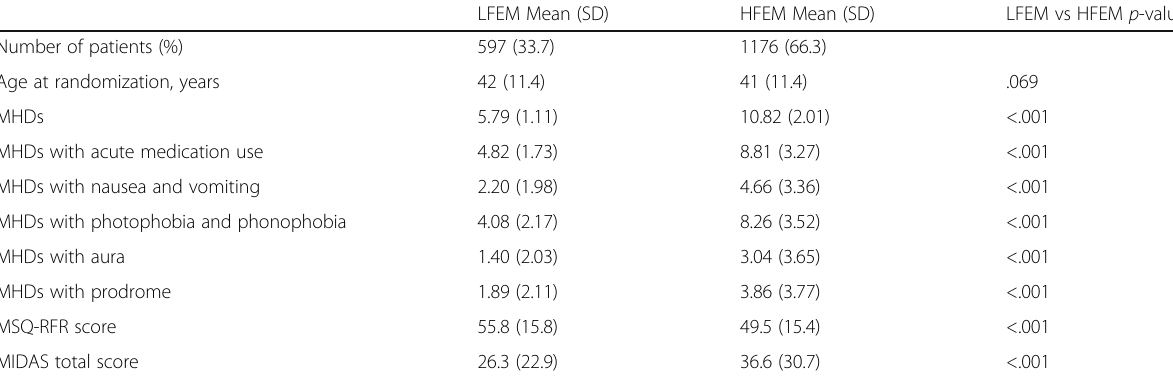
Table 1 Baseline characteristics